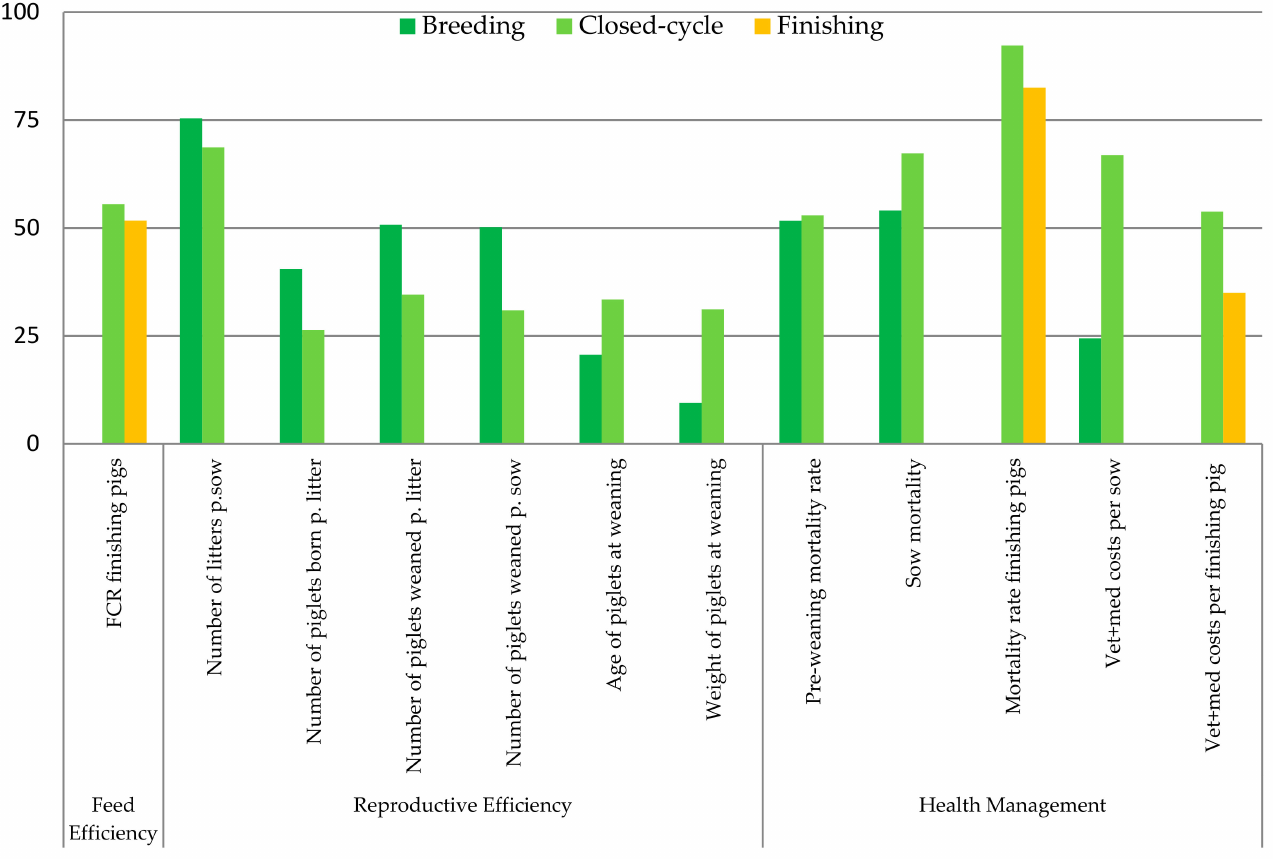
Figure 2. Results of economic sustainability assessment of the theme “technical performance” on the pig farms according to scaled indicators (results of indicators recalculated to a scale ranging from 0% to 100%, where 100% is the highest sustainability level and 0% is the lowest sustainability level. Source: Own